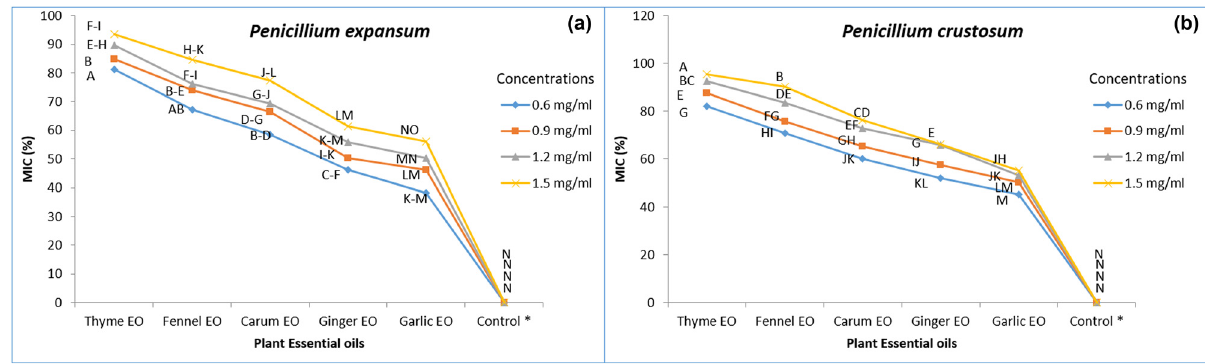
Figure 6: E ff ect of plant EOs at four concentrations ( 0.6, 0.9, 1.2, and 1.5 mg/mL ) on growth inhibition of ( a ) Penicillium expansum and ( b ) Penicillium crustosum . Mean values in the columns separated by Tukey ’ s HSD test at P ≤ 0.05 followed by the same letters are not signi fi cantly di ff erent from each other; Control* ( without application of plant EO ) .